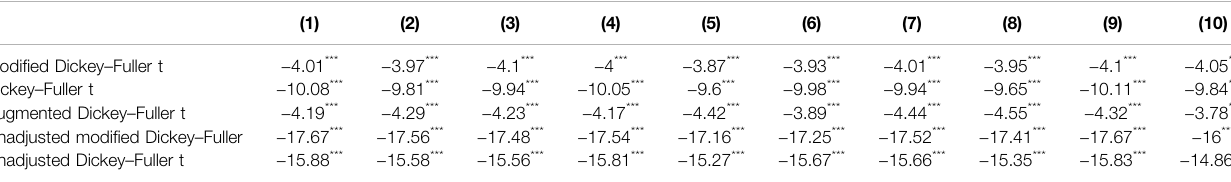
TABLE 9 | Panel cointegration